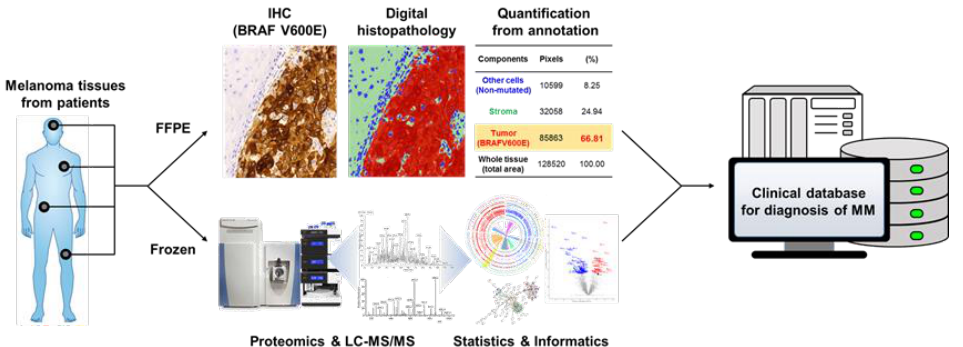
Figure 4. Figure 4. A systematic approach for melanoma tissue that combines digital histopathology and proteomics.